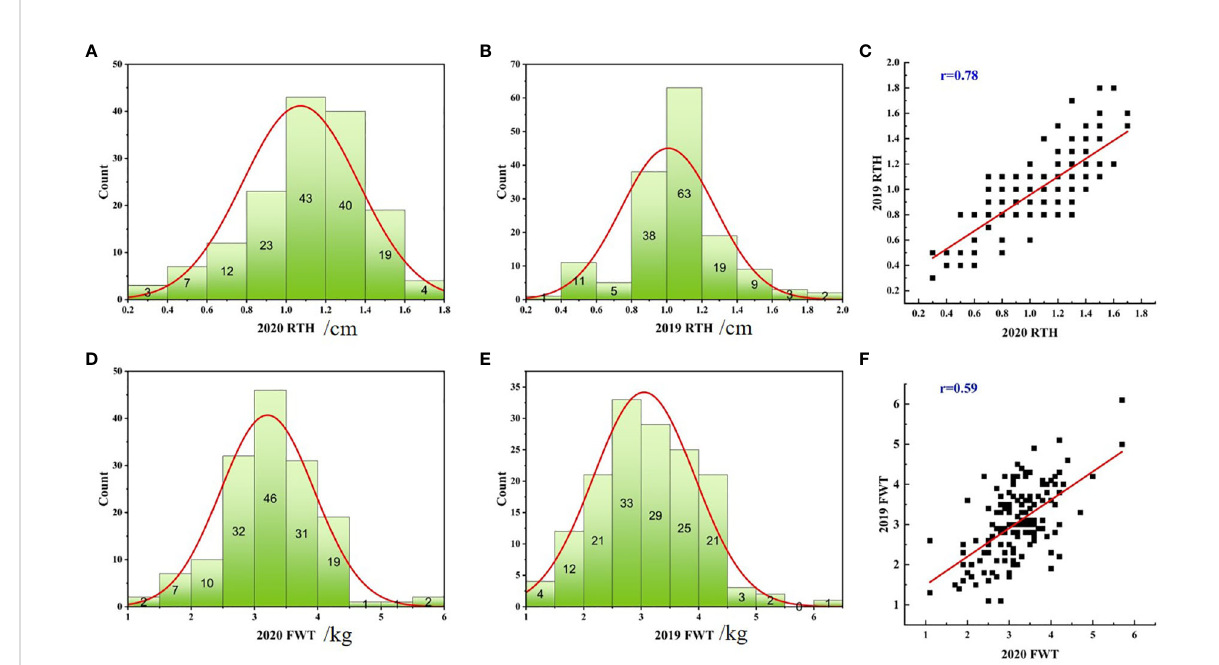
FIGURE 1 Distribution histograms and correlation graphs of rind thickness and single fruit weight of 151 watermelon accessions in 2019 and 2020. Statistical histogram of the rind thickness in 2020 (A) , the rind thickness in 2019 (B) , the single fruit weight in 2020 (D) and the single fruit weight in 2019 (E) , respectively. Correlation diagram of two-year data of rind thickness (C) and single fruit weight (F) , respectively.